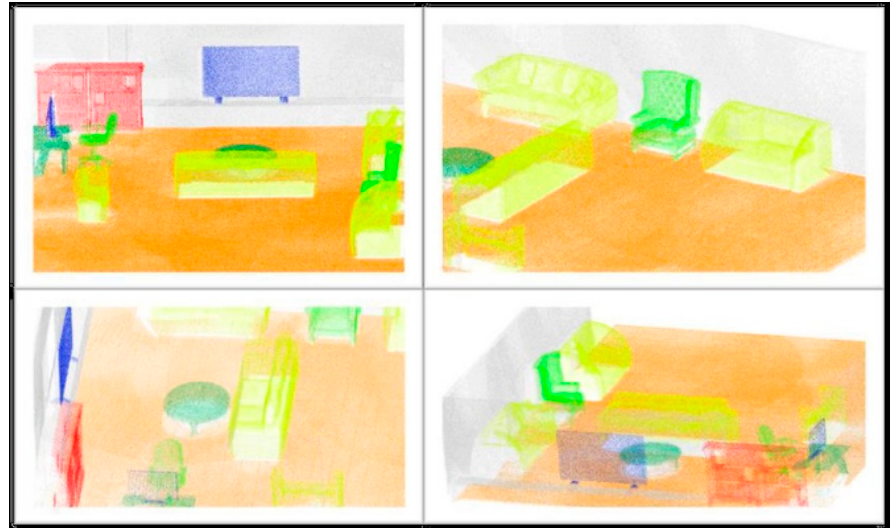
Figure 15. Synthetic point cloud generated with semantic classification seen at different angles. Classes: Red—Bookcase, Yellow—Sofa, Dark green—Table, Light green—Chair, Blue—Monitor/TV, Gray—Wall, and Orange—Floor [29].